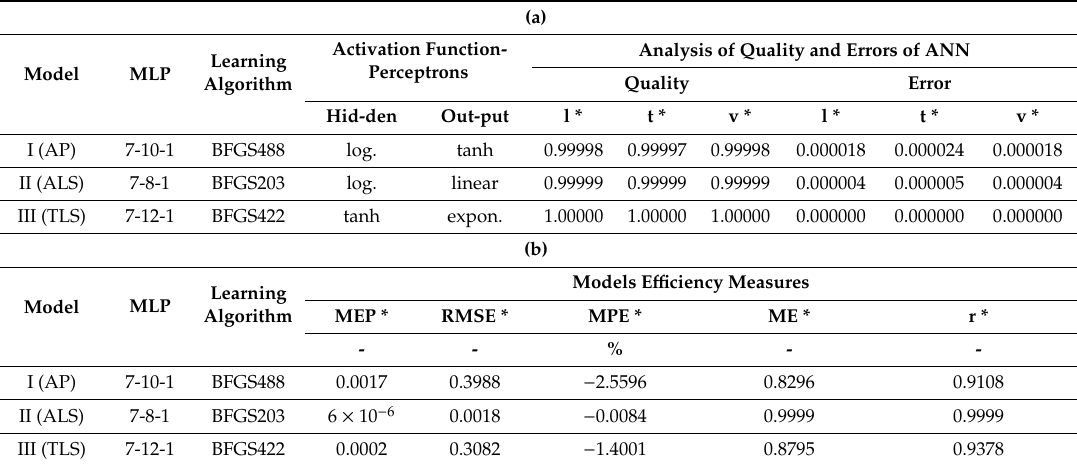
Table 4. Summary of ANN analysis: ( a ) Fit Quality, ( b ) Error Measures.